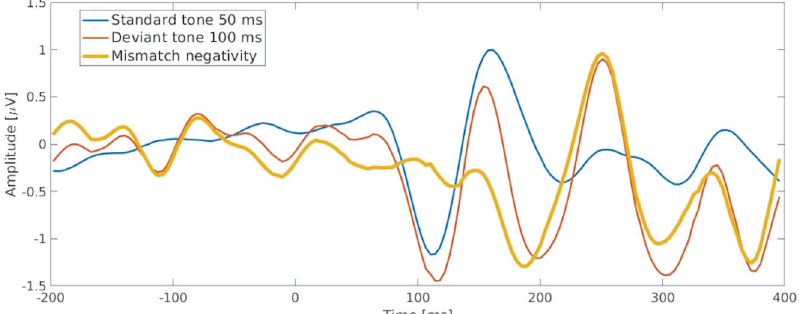
Fig. 5 Auditory-evoked potential (AEP) of standard and deviant tones during the MMN paradigm calculated by averaging F 3 , F Z , F 4 , C 3 , C Z , and C 4 channels. Additionally, the mismatch-negativity difference wave obtained by subtracting the standard from deviant event-related potentials is also shown.